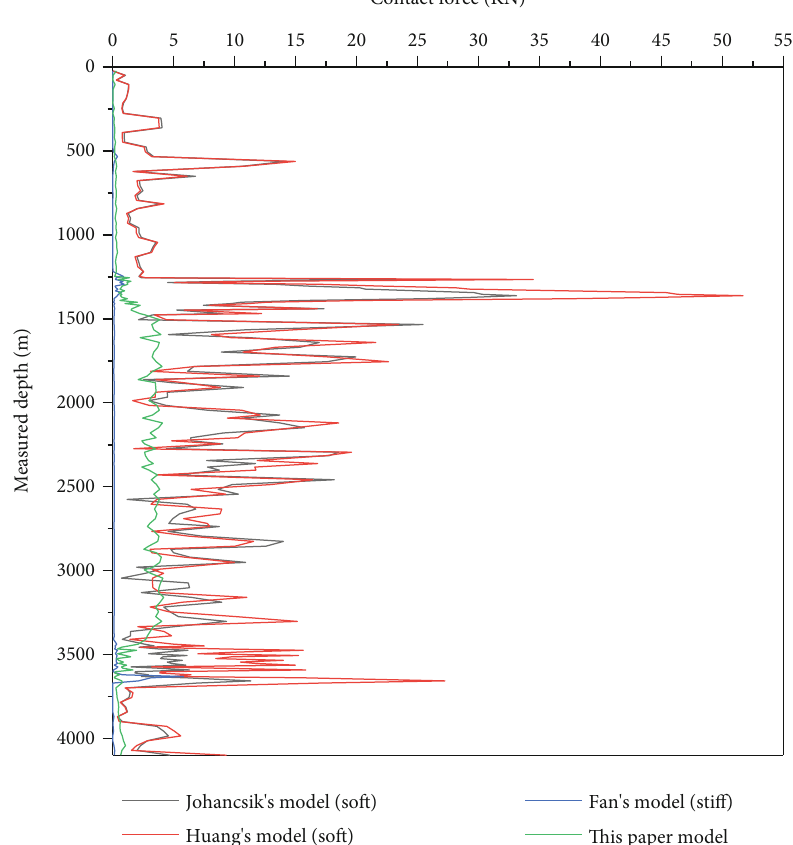
Figure 9: Contact force on the casing string using di ff erent